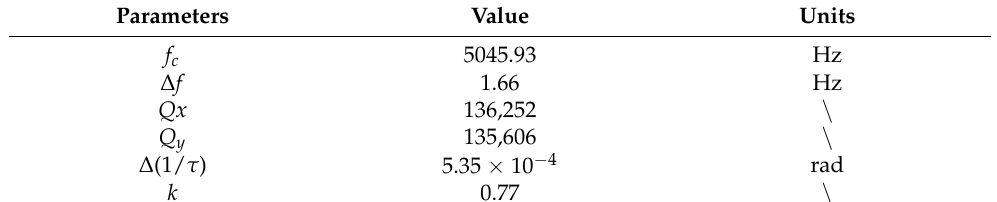
control program.